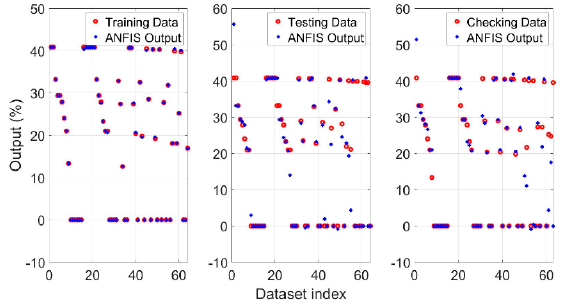
Figure 11. Process of training, testing and checking.